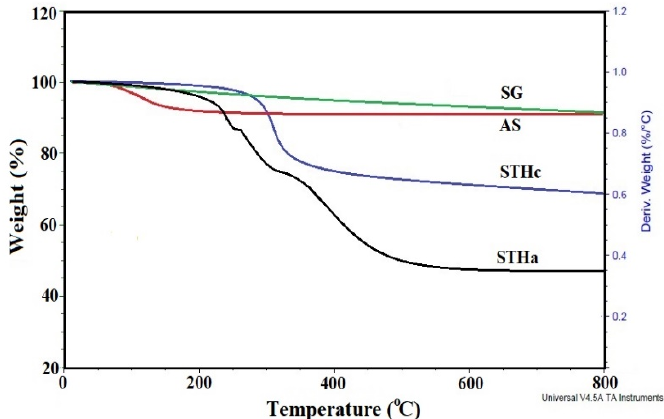
Figure 3. Thermogravimetric analyses (TGA) thermograms of SG, ASG, STHc and STHa.